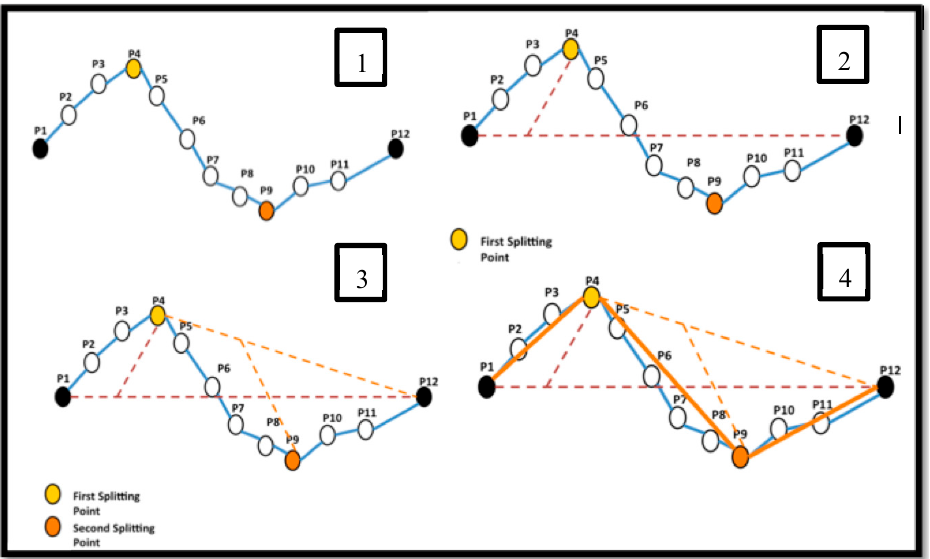
Figure 5. The extended Douglas–Peucker algorithm taking distance and time for simplification and segmentation of trajectories.